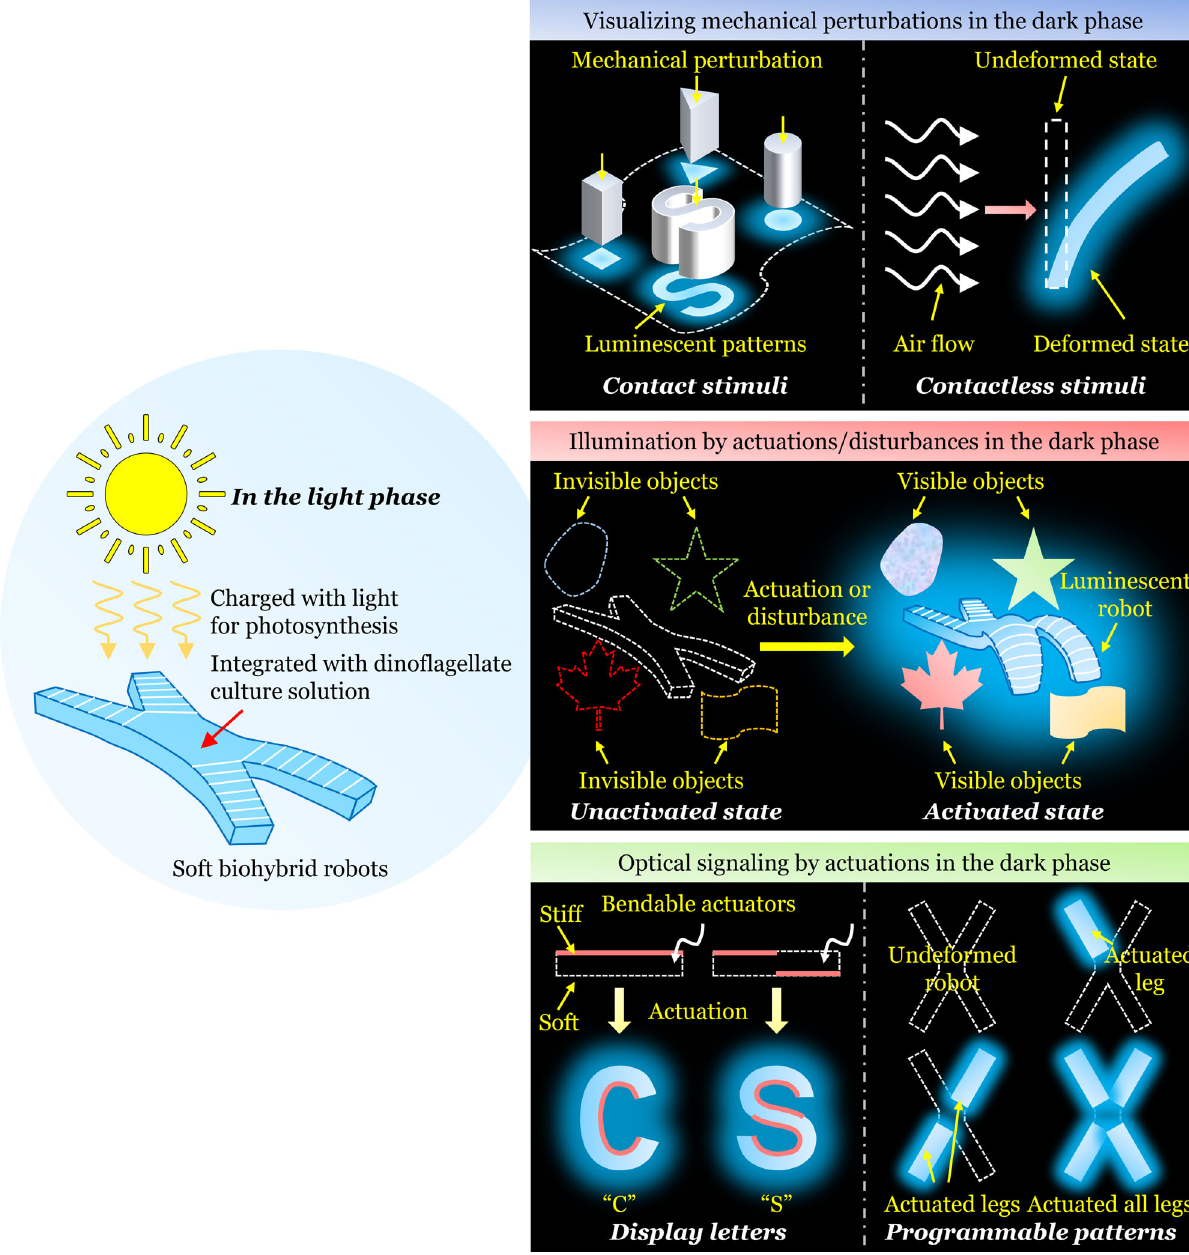
Fig. 1 Schematic of the working principle and potential applications of the biohybrid mechanoluminescence. In the light phase, the soft biohybrid robot integrated with dino fl agellate culture solution is charged with sunlight for photosynthesis to produce oxygen, providing energy for the organism. In the dark phase, the mechanically induced bioluminescence of the soft biohybrid robot can visualize mechanical perturbations, illuminate surrounding area, and produce optical